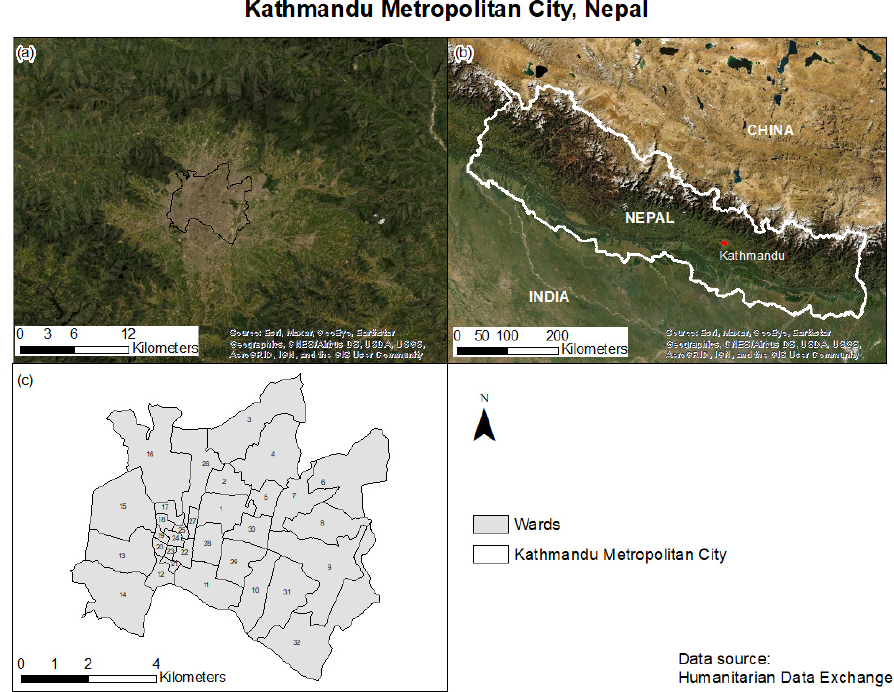
Figure 1. Kathmandu Metropolitan City, Nepal; ( a ) Geographic location of KMC; ( b ) Land cover comparison between KMC and its surrounding; ( c ) Administrative wards in KMC.